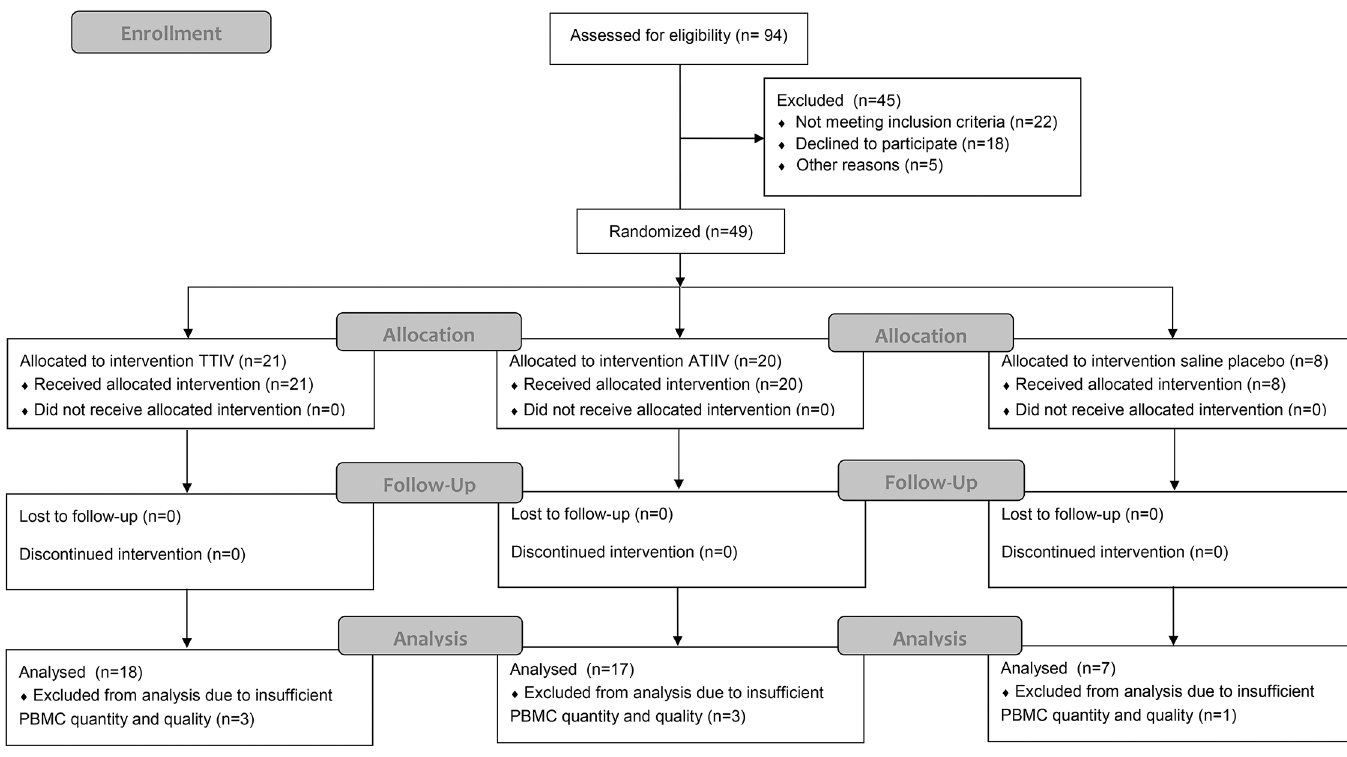
Fig 1. CONSORT Flow